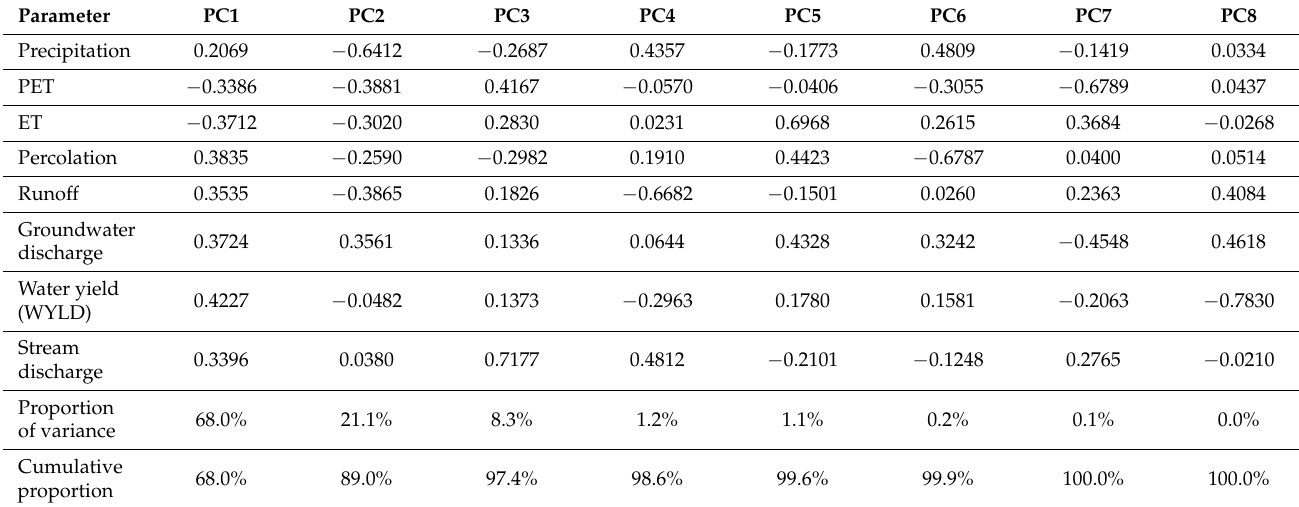
Table 2. Component loading coefficients from principal component analysis. PC denotes principal component and the number refers to the number of components. For example, PC1 is principal component 1.